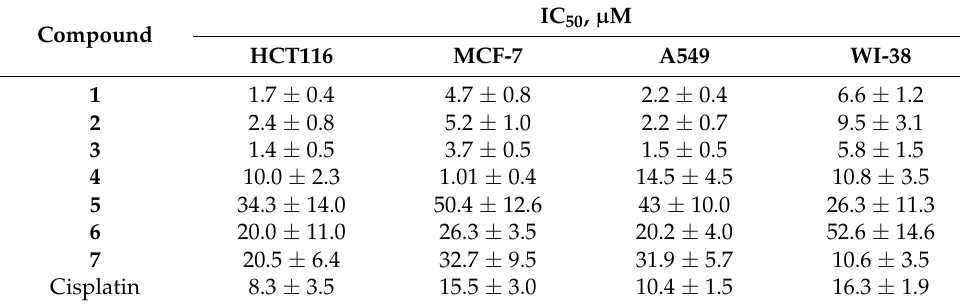
Table 3. Results of MTT-test for synthesized compounds.